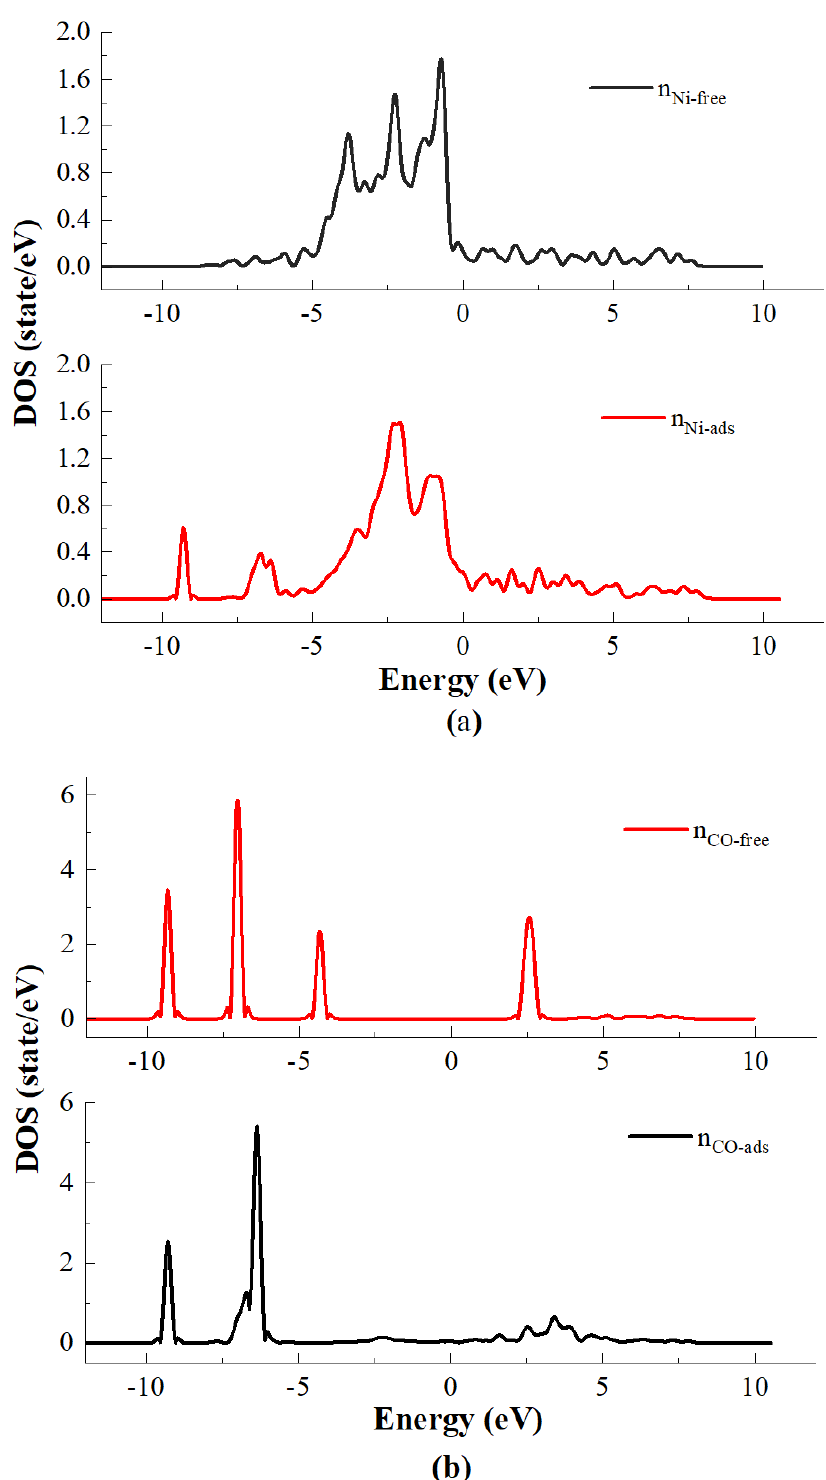
Figure 7. Electronic density of states of ( a ) Ni and ( b ) CO before and after